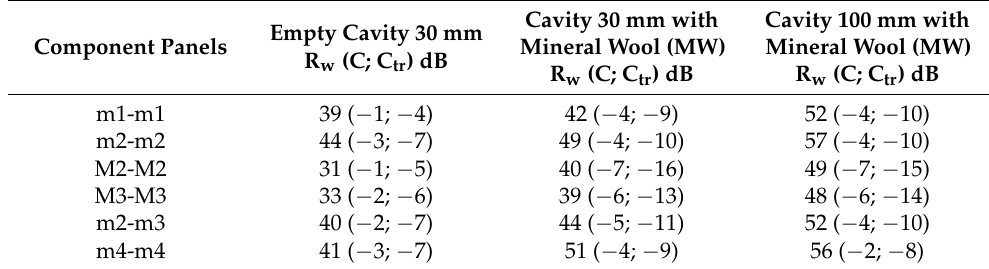
models (4190 mm × 2720